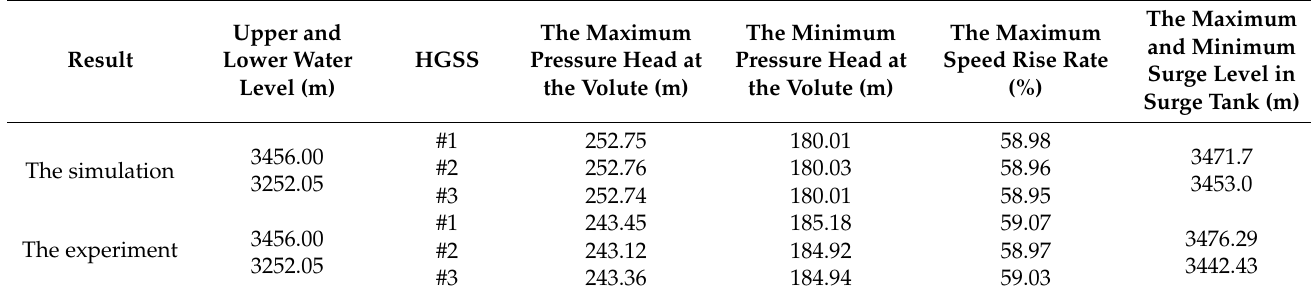
Table 2. The comparison of the simulation results and the experiment results.